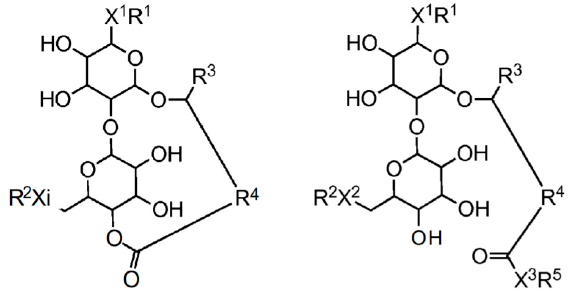
Figure 5. Modified sophorolipids for inhibition of plant pathogens. Source: [72].